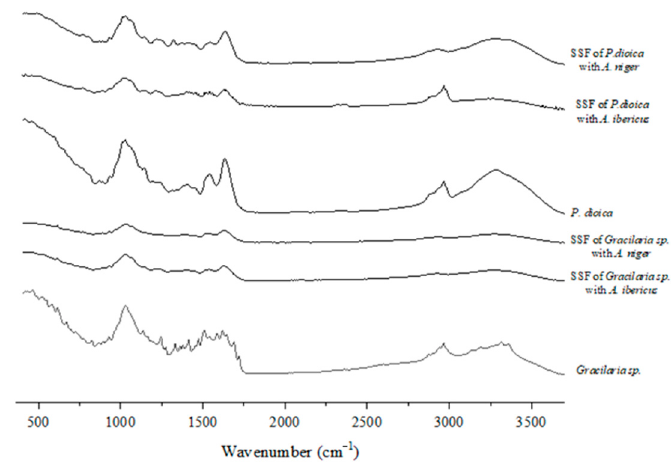
Figure 3. FTIR-ATR spectra of red seaweeds. Figure 4. FTIR-ATR spectra of green seaweeds.